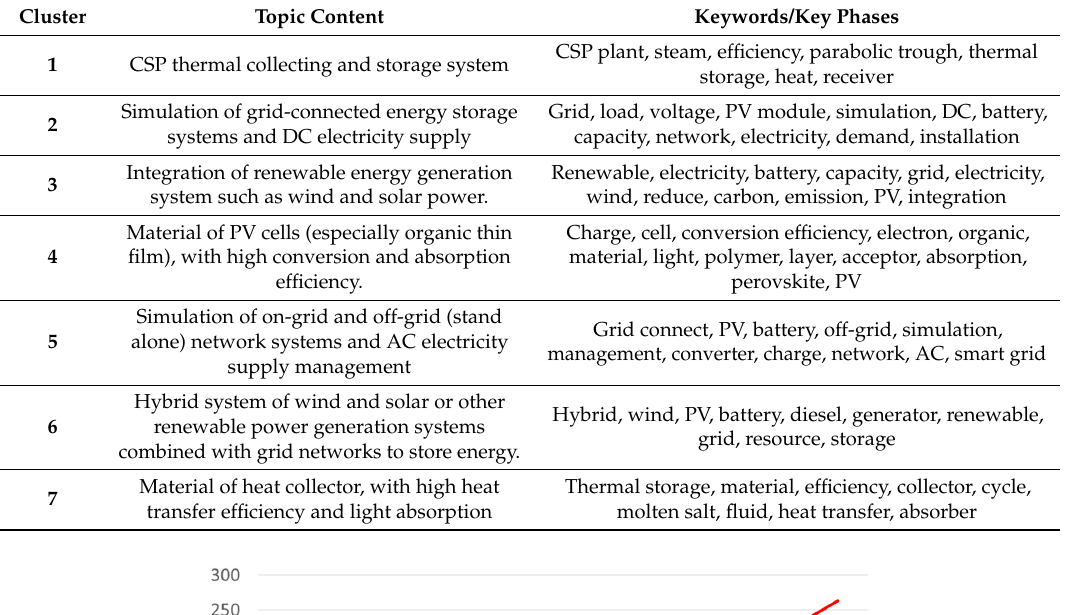
Keywords/Key Phases